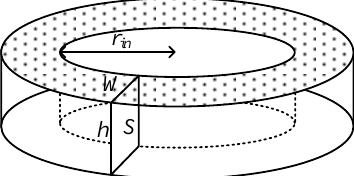
Figure 3. Schematic illustration of a toroidal core for a transformer.